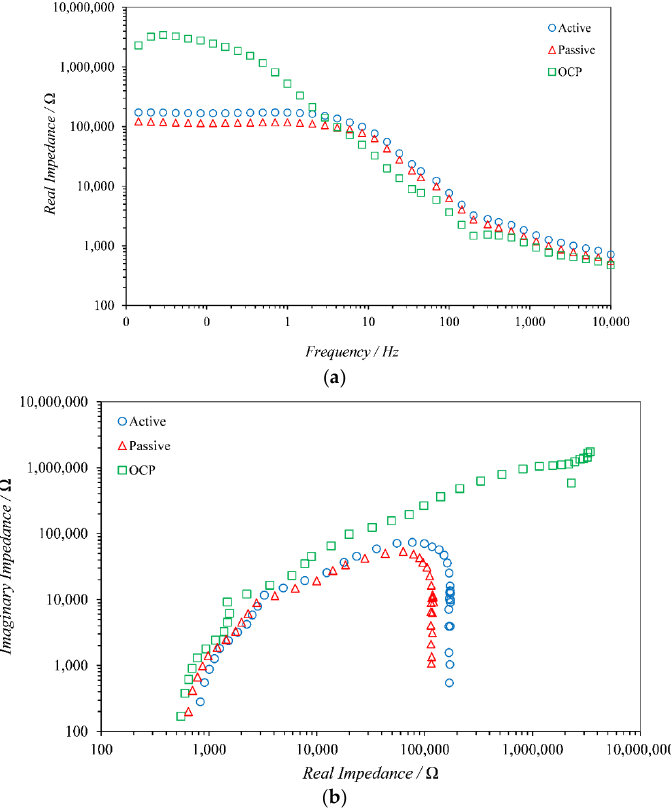
Figure 8. ( a ) Bode impedance, ( b ) Nyquist plots of CoNiCrAlY coatings after heat treating of sample to 1000 °C and polarizing to 100 mV and 500 mV.